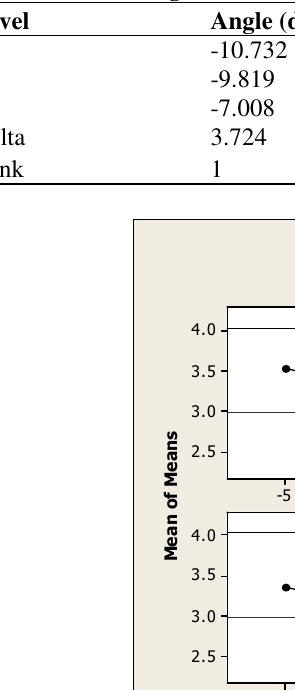
Response table for signal to noise ratios smaller is better.